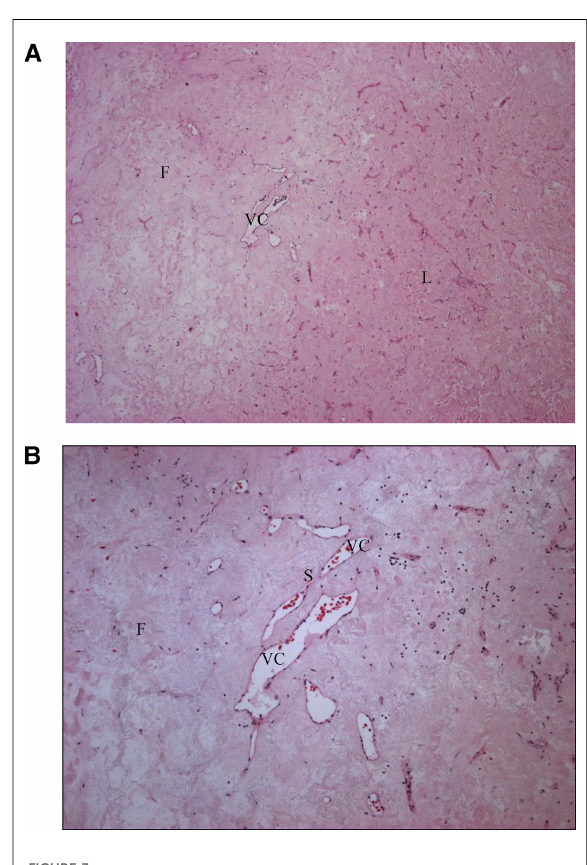
FIGURE 3 Sclerosed hemangioma, histological appearances. A rich paucicellular fi brous (F) stroma is distinguished from the Normal liver (L) tissue. Irregular vascular channels (VC) are separated by endothelial cells with thin fi brous septa (S). ( A ) Histology. Hematoxylin – eosin, magni fi cation ×40. ( B ) Histology, Hematoxylin – eosin, magni fi cation